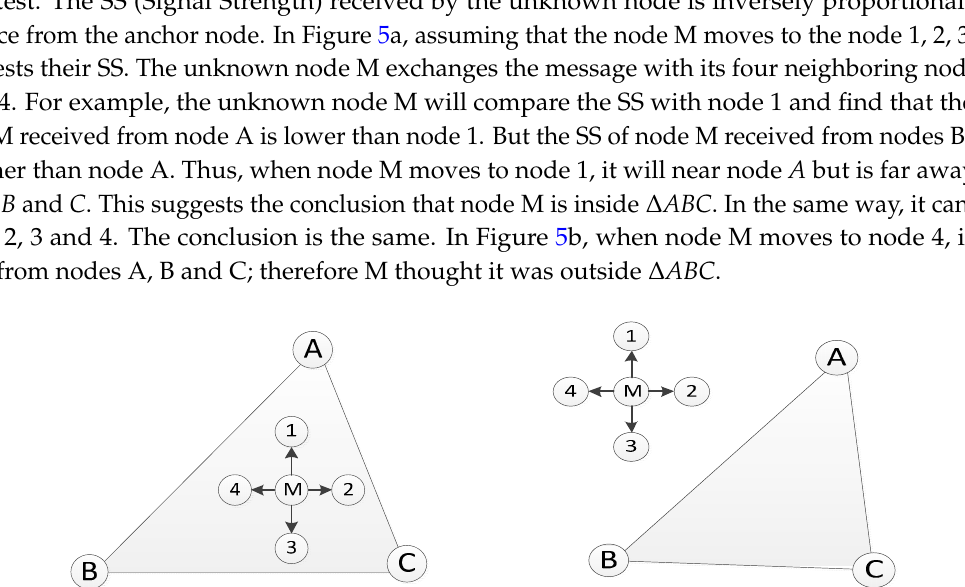
Figure 4. APIT localization test principle schematic drawing. ( a ) principles of PIT (unknown node in the triangle); ( b ) principles of PIT (unknown node out of the triangle).